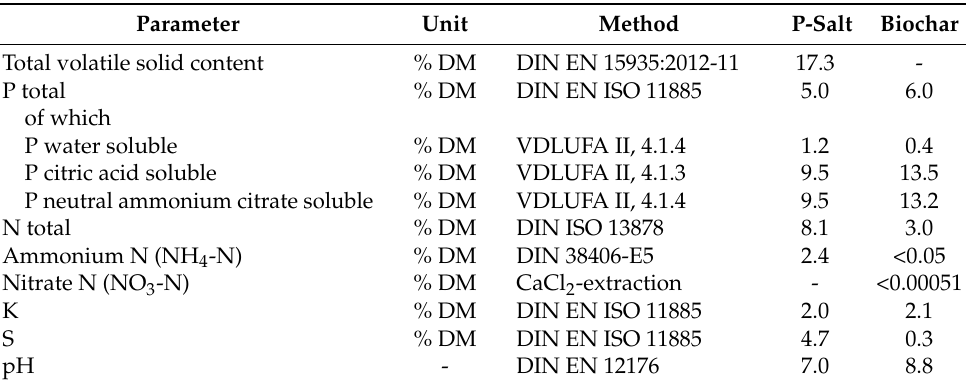
Table 1. Characteristics of phosphate salts (P-Salt) and